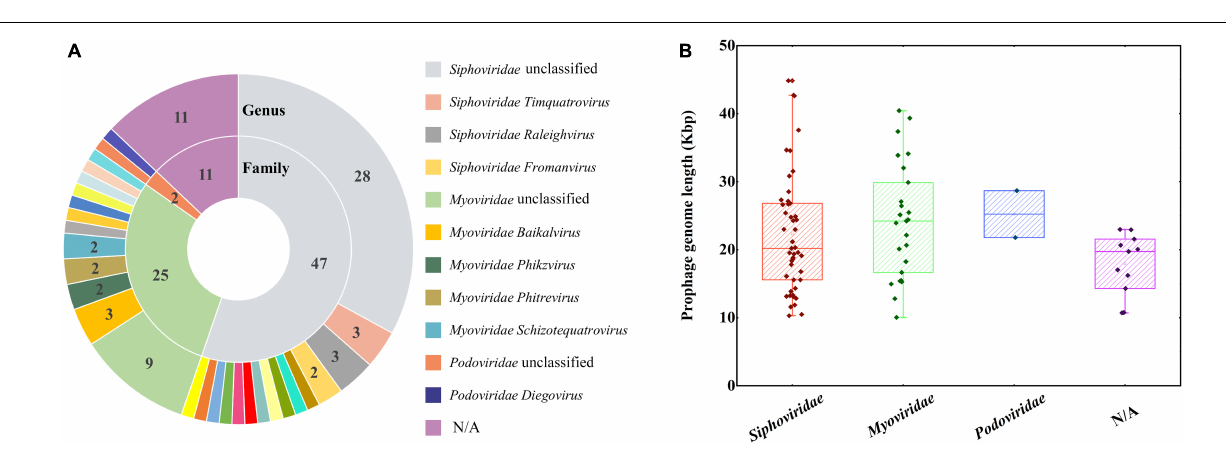
FIGURE 6 | The closest phages classified according to family and genus levels (A) . The numbers represented the closest phages belonging to the different families. A boxplot of prophage genome lengths based on closest phages family taxonomy (B)